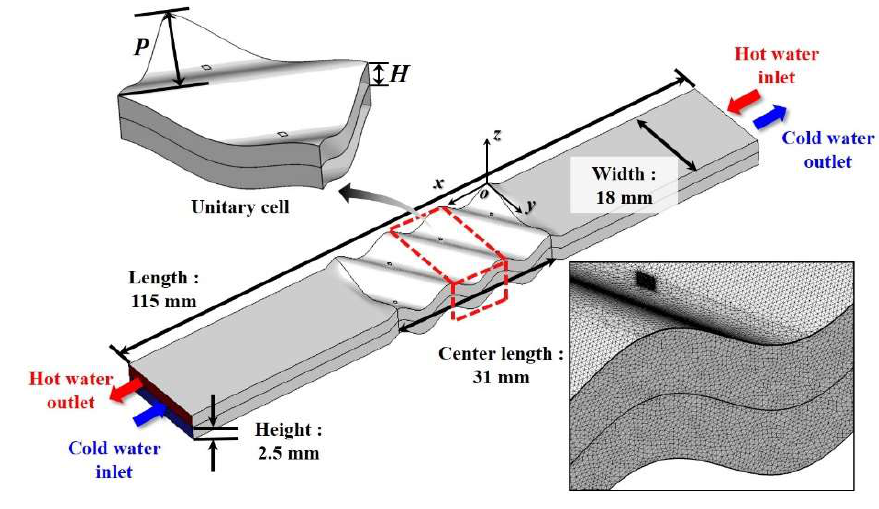
Figure 2. Computational domain and grid system.